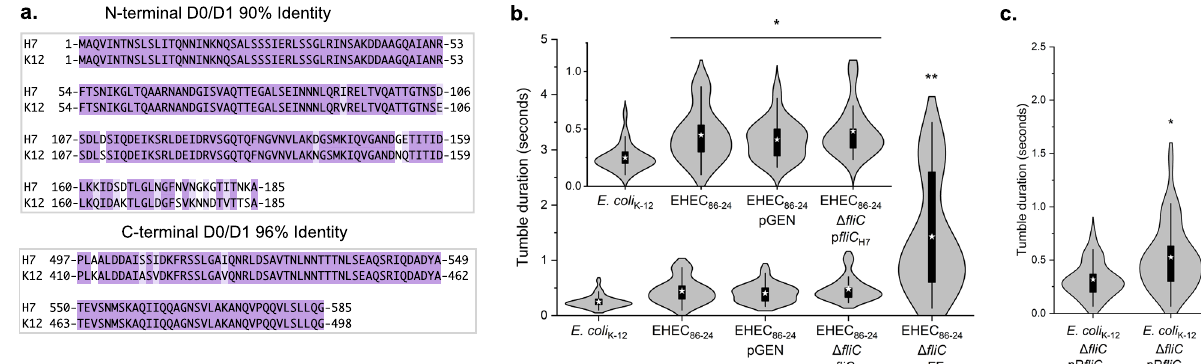
Fig. 8 The H7 ODS prolongs E. coli tumbling. a Alignment of EHEC H7 and E. coli K-12 sequences in domains D0 and D1. Color indicates the conservation of chemical properties. b Tumbling times for various strains of E. coli . The strains are E. coli K-12, WT EHEC O157:H7 (EHEC 86 – 24 ), WT EHEC O157:H7 with empty pGEN vector (EHEC 86 – 24 pGEN), EHEC O157 Δ fl iC complemented with the H7 fl iC in the pGEN vector (EHEC 86 – 24 Δ fl iC pFliC H7 ), and the EHEC H7 FF mutant (EHEC 86 – 24 Δ fl iC pFF) are shown. The inset shows the tumbling times for all strains except the FF mutant. At least 50 cells were analyzed for each measurement. Asterisks represent statistically signi fi cant differences of the given strain(s) from other strain(s) (* P < 0.01; ** P < 10 − 6 ). The p -values for EHEC 86 – 24 , EHEC 86 – 24 pGEN, and EHEC 86 – 24 Δ fl iC pFliC H7 compared to E. coli K-12 are 0.000106, 0.000105, and 0.000006 respectively. The p -value for EHEC 86 – 24 Δ fl iC pFF compared to E. coli K-12 is 0.000000735. Each strain left to right the maximum (max) and minimum (min) tumbling times were 0.63 s max and 0.1 s min for E. coli K-12, 0.93 s max and 0.1 s min for EHEC 86 – 24 , 0.87 s max and 0.17 s min for EHEC 86 – 24 pGEN, 1.1 s max and 0.23 s min for EHEC 86 – 24 Δ fl iC pFliC H7 . c Tumbling times for E. coli K-12 HCB5 ( Δ fl iC ) cells with the non-sheathed H48 fl agellar fi lament ( E. coli K-12 Δ fl iC pP fl iC H48 ) and the sheathed H7 fl agellar fi lament ( E. coli K-12 Δ fl iC pP fl iC H7 ). Asterisks represent statistically signi fi cant differences of the indicated strain(s) from other strain(s) (* P < 0.003). The exact p -value is 0.001845. For 8b and 8c signi fi cance was determined using a two-tailed t -test assuming two samples with unequal variance. Tumbling events for 30 unique cells over three independent experiments were measured for each condition. The boxes in the violin plots represent the interquartile range. The whiskers of the box plot correspond to the outer most data points that is within 1.5 multiplied by the interquartile range. Table 2 Swimming velocity measurements for E. coli K-12 and EHEC strains.